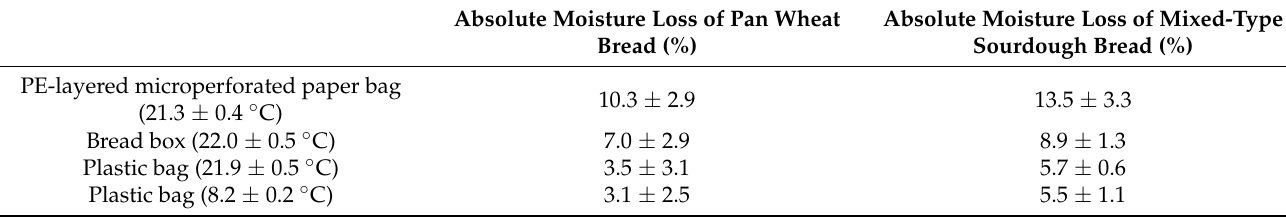
Table 2. Absolute moisture loss of bread samples (crumb and crust) for different storage conditions and bread types after a storage period of ten days (x ± STD, n =